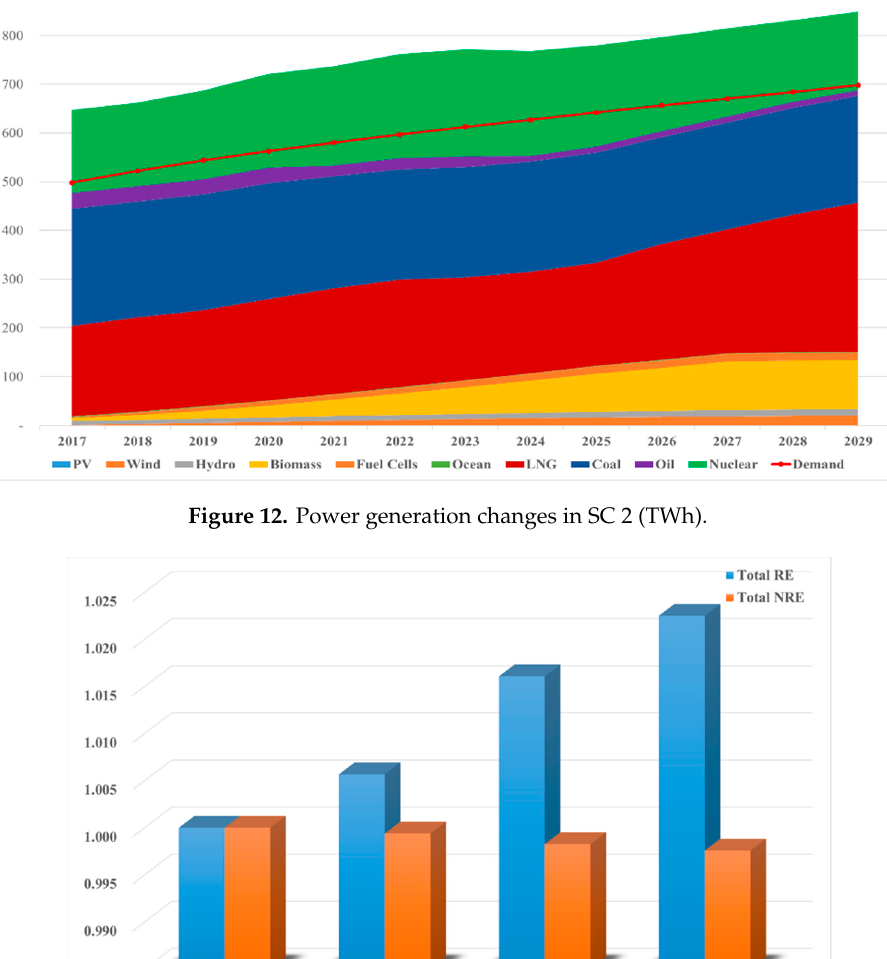
Figure 12. Power generation changes in SC 2 (TWh).